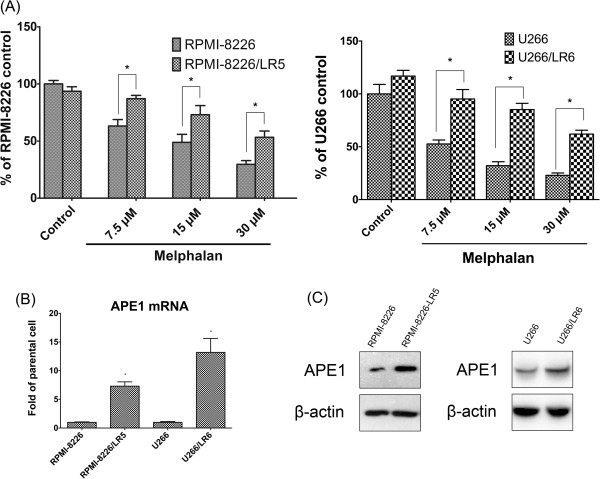
APE1 overexpression in melphalan-resistant MM cell lines RPMI-8226/LR5 and U266/LR6. (A) CCK-8 assay indicated that RPMI-8226/LR5 and U266/LR6 show more resistance to melphalan than their parental cell lines RPMI-8226 and U266. All cell lines were treated with three different doses of melphalan for 48 hours then cell viability was assayed using the CCK-8 assay. Results are shown as mean ± SD and were from three separate experiments. The significance was analyzed by Student t test. Stars (*) represent that the differences between RPMI-8226/LR5 and RPMI-8226 or between U266/LR6 and U266 are statistically significant (p < 0.01). Differential APE1 expression at the mRNA (B) and protein (C) level was assayed using quantitative RT-PCR and Western blots, respectively. The bar graph showing the quantitative results of APE1 mRNA levels was from three independent experiments. Representative blot images are shown and β-actin was used as a loading control.